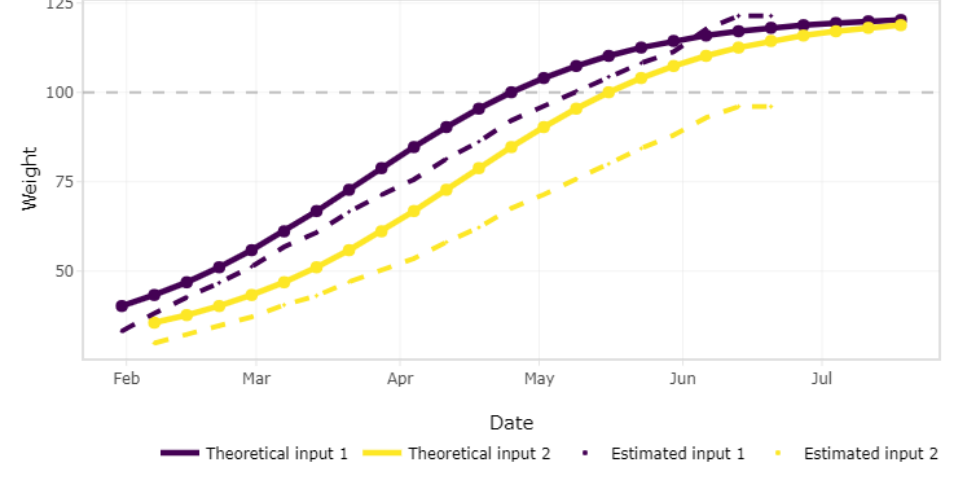
Figure 9. Animal average weight.